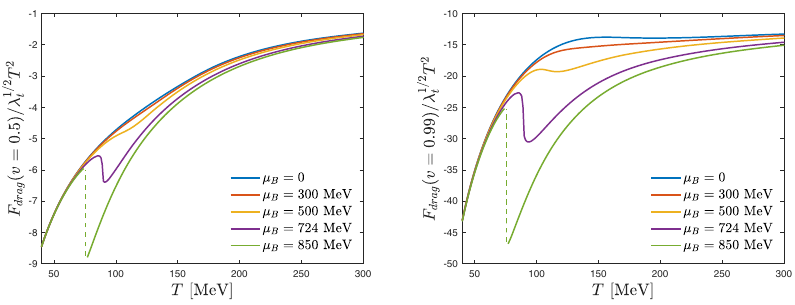
Figure 1. Left: normalized pressure as a function of the temperature for di ff erent values of µ B / T and its comparison with the most recent lattice results. Right, the pressure in the phase diagram with the location of the CEP (red point). Figure 2. Heavy quark drag force at v = 0 . 5 (left) and v = 0 . 99 (right) as a function of the temperature for several values of µ B